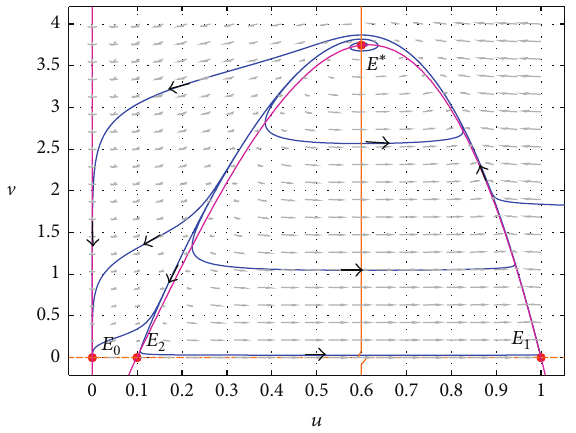
Figure 1: Phase portrait of model (5). The parameters are taken as 𝛼 = 1.11 , 𝛽 = 0.1 , 𝛾 = 11.25 , and 𝛿 = 0.36 . The horizontal axis is the prey population 𝑢 , and the vertical axis is the predator population V . = (0,0) is a stable node, 𝐸 = (1,0) and 𝐸 = (0.1, 0) are saddle 𝐸 0 1 2 points, and 𝐸 ∗ = (0.6, 3.75) is